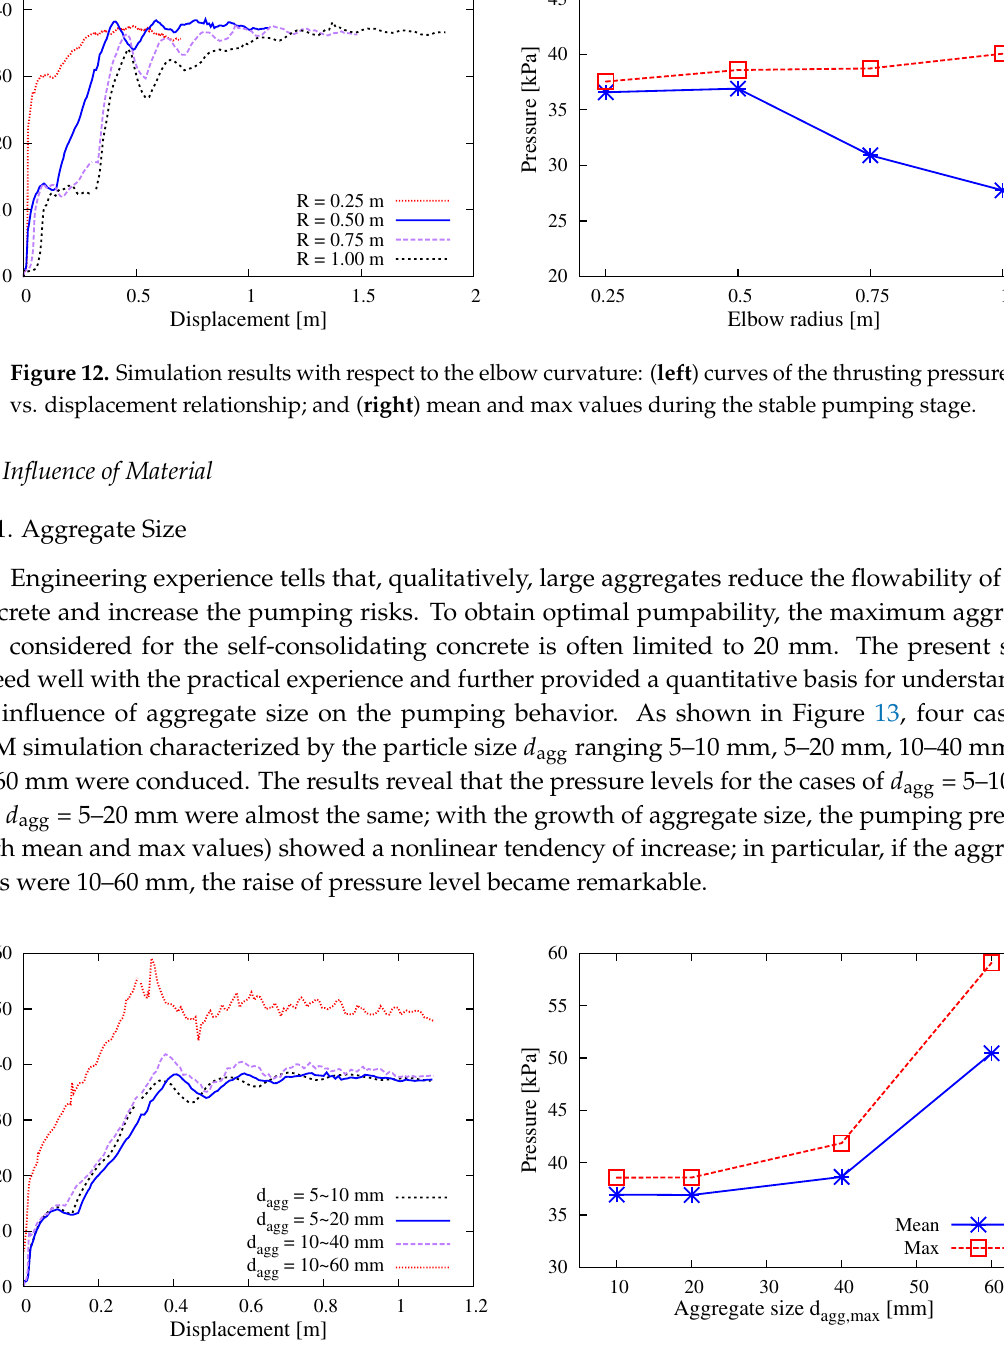
Figure 13. Simulation results with respect to the aggregate size: ( left ) curves of the thrusting pressure vs. displacement relationship; and ( right ) mean and max values during the stable pumping